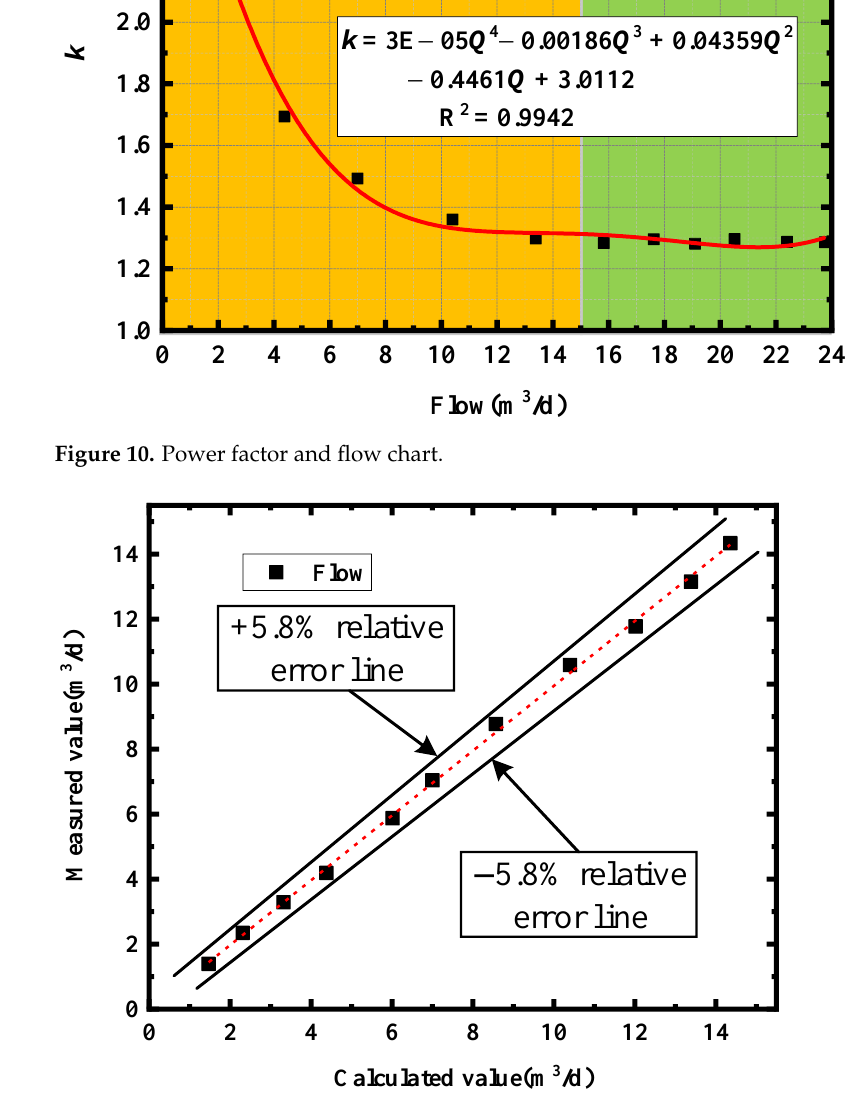
Figure 10. Power factor and flow chart.